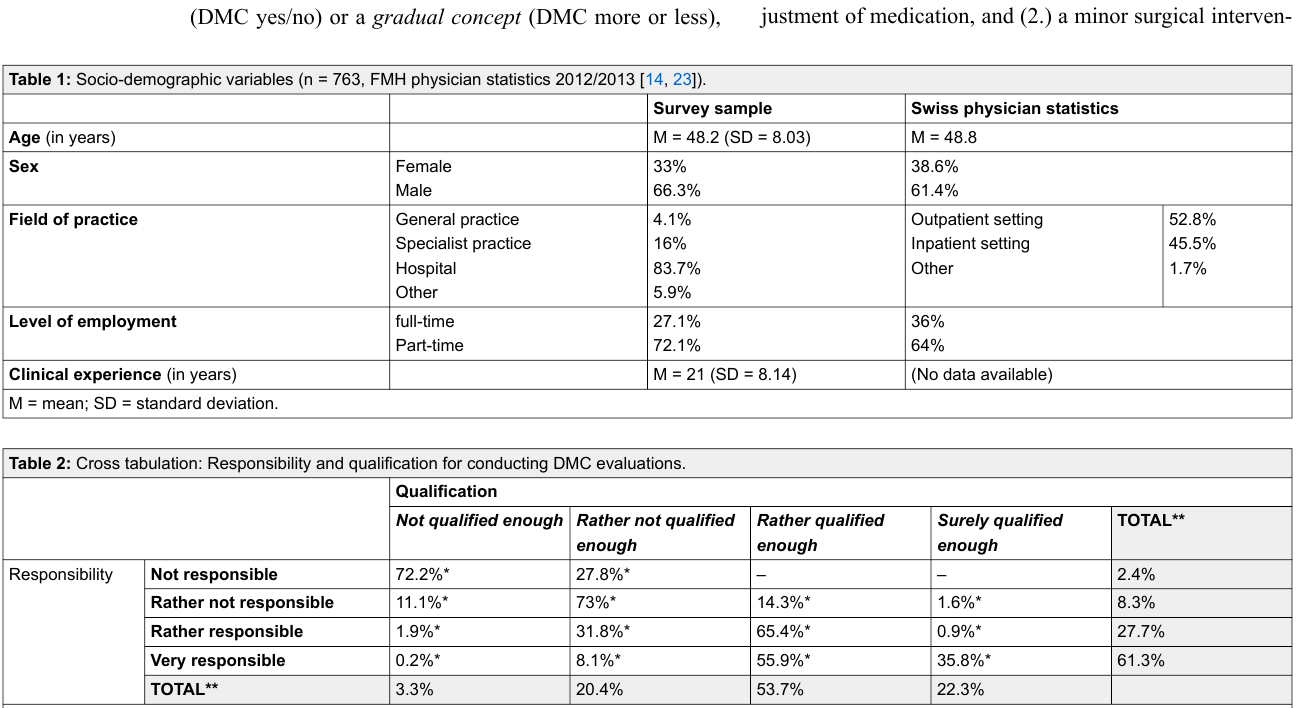
Table 1: Socio-demographic variables (n = 763, FMH physician statistics 2012/2013 [14, 23]).